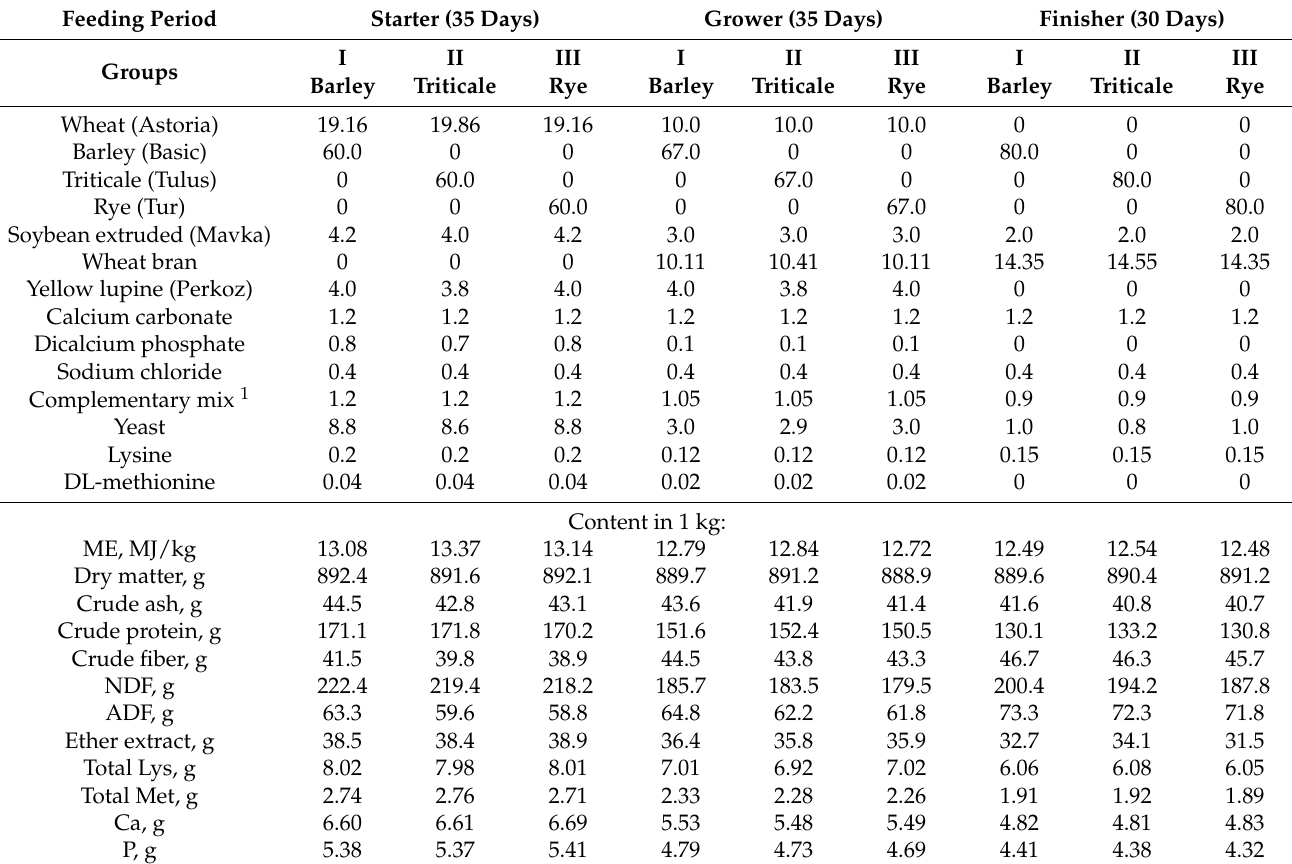
Table 1. Composition (%) and nutritive value of fattening pig